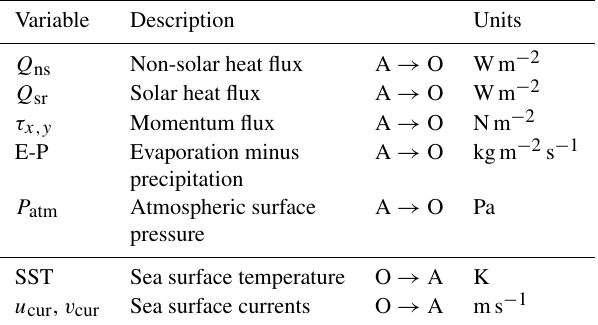
Table 1. Variables exchanged between NEMO (O) and AROME/- SurfEx (A) via the OASIS3-MCT